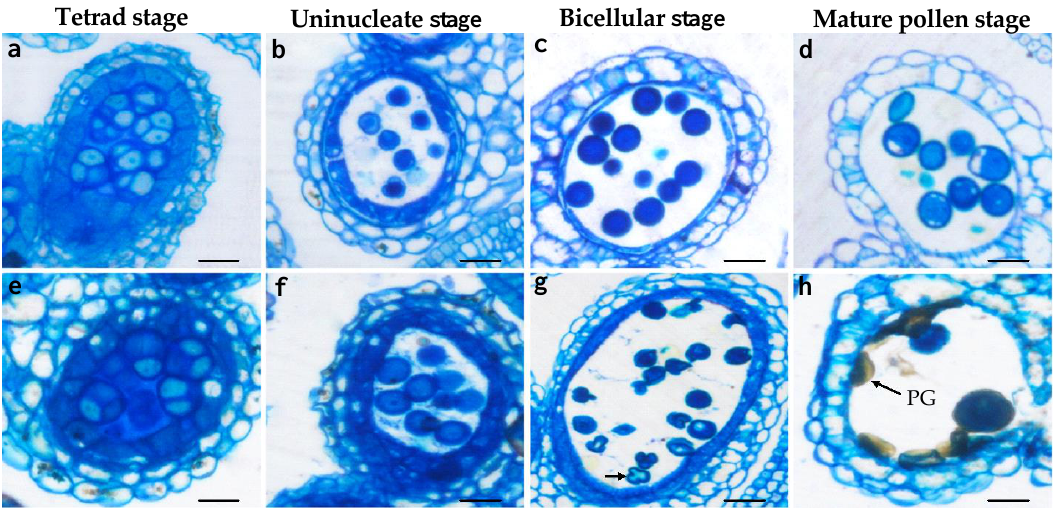
Figure 5. Semithin section observation of anther development in Bra-MIR319a overexpressing transgenic Arabidopsis . ( a – d ) Different anther development stages of wild-type plants and Bra-MIR319a transgenic plants ( e – h ). Arrows show the abnormal microspores. PG, pollen grain. Scale bars, 50 μm.